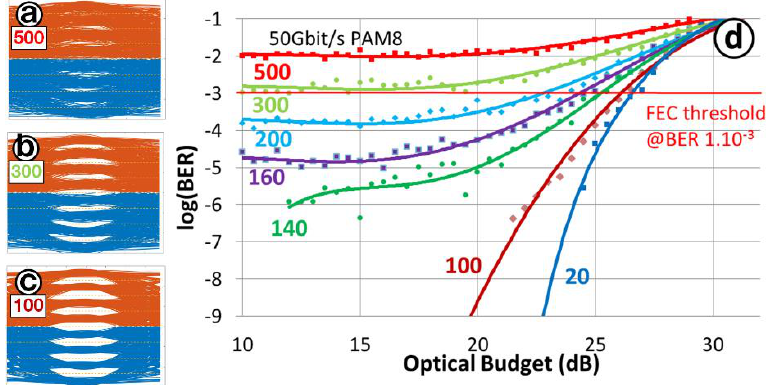
Figure 6. PAM8 eye diagrams for standard deviations of the decoder’s Gaussian noise of ( a ) 500 a.a.u., ( b ) 300 a.a.u., and ( c ) 100 a.a.u. ( d ) Simulated and polynomial approximations of BER versus Optical Budgets for different standard deviations of the simulated decoder’s noise.